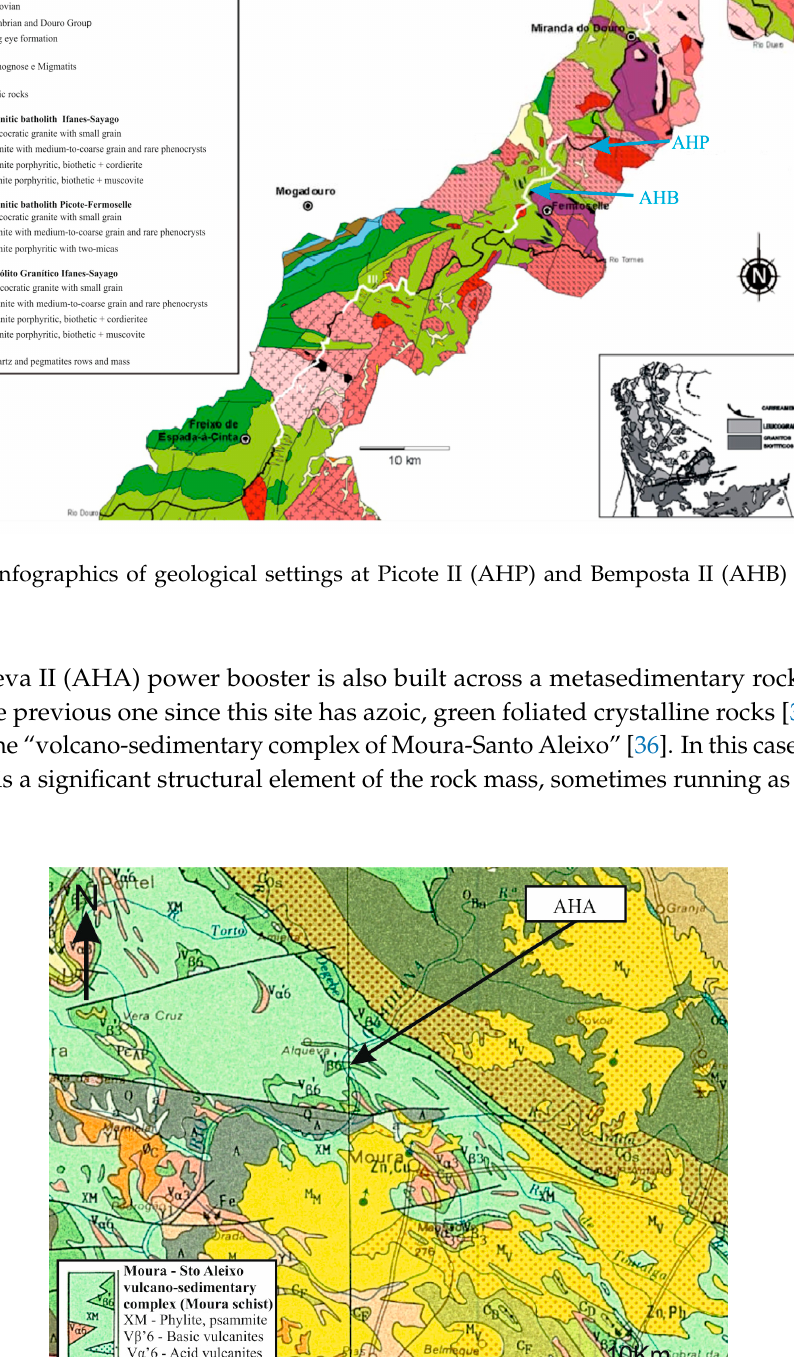
Figure 5. Infographics of the geological settings of Alqueva II (AHA) (adapted from [37]).